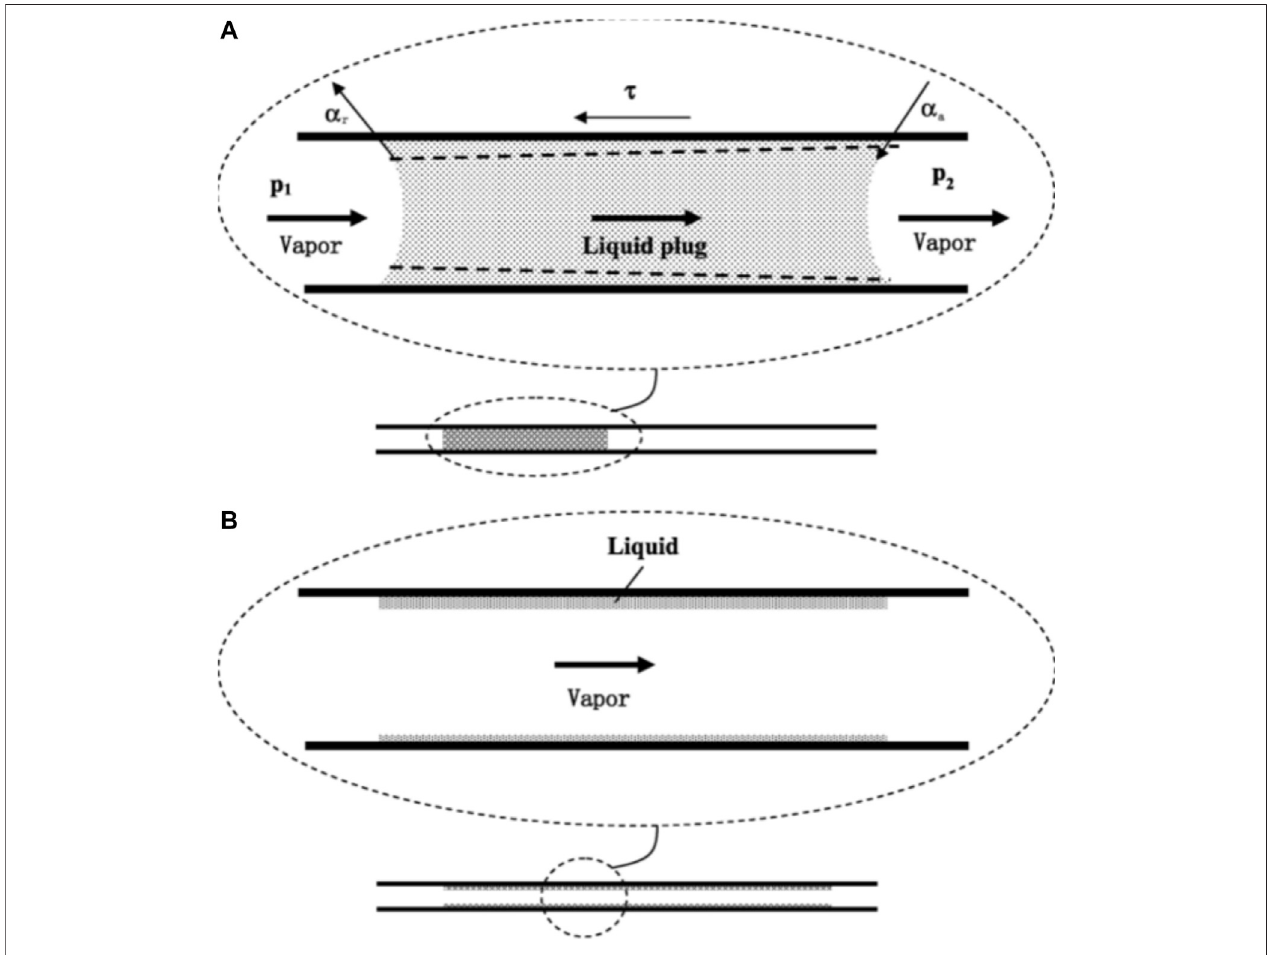
FIGURE 2 | (A) The liquid plug and the vapor slugs coexist, and (B) the vapor slugs penetrate the liquid plug and fi lls the entire capillary tube (Yin et al., 2016).